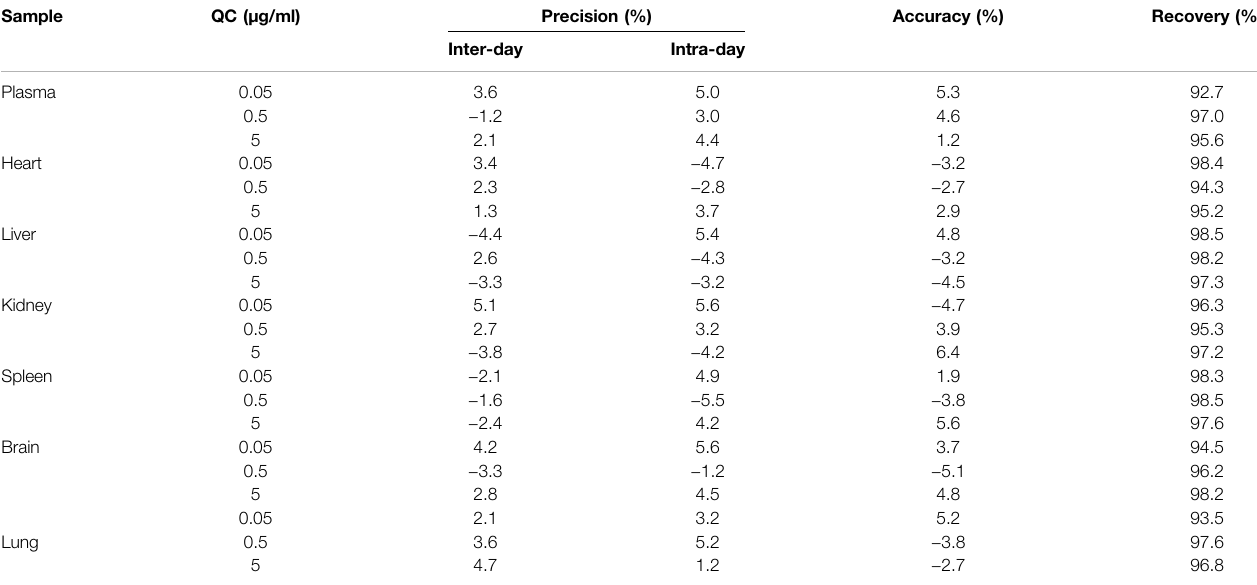
TABLE 3 | Precision, accuracy, and recover of the method used for the determination of anwulignan. Sample QC (µg/ml)